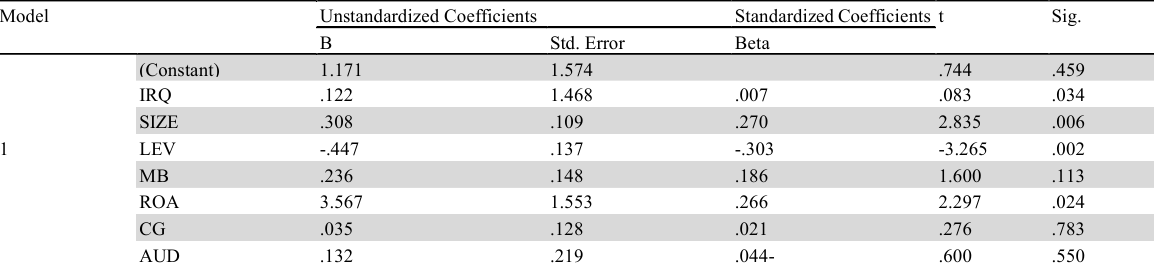
The results of regression analysis Model